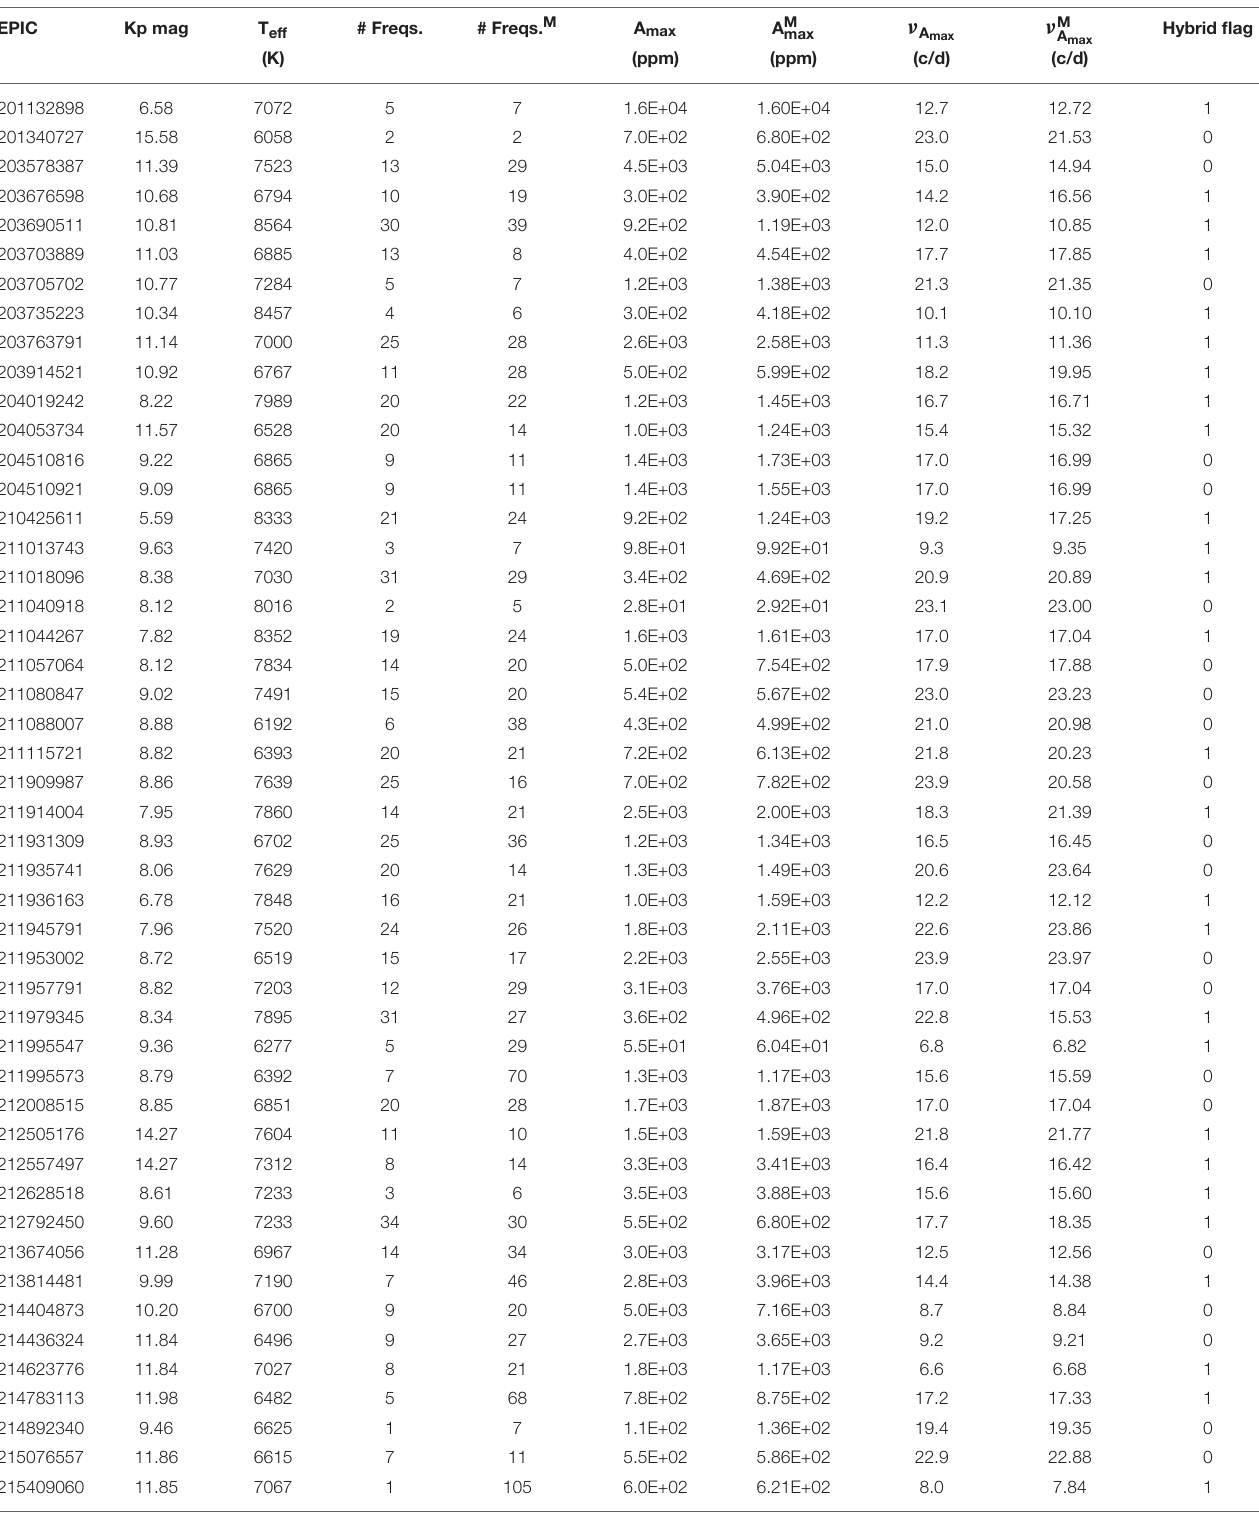
TABLE 3 | Summary of pulsation properties of δ Sct candidates a .